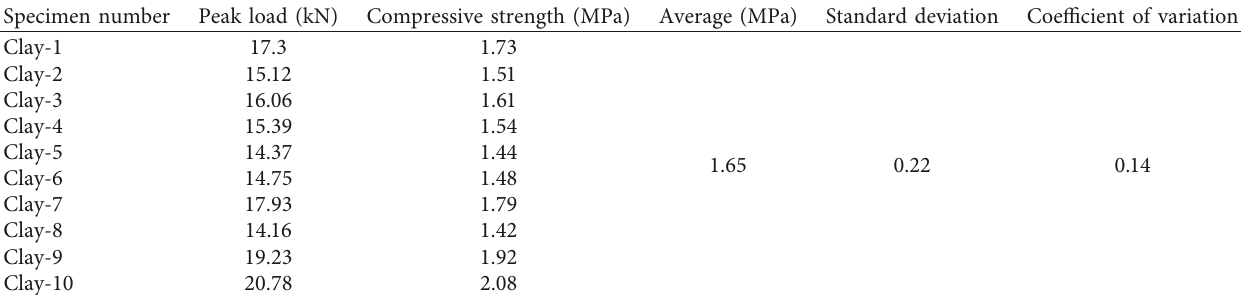
Table 4: Results from red soil cubes.